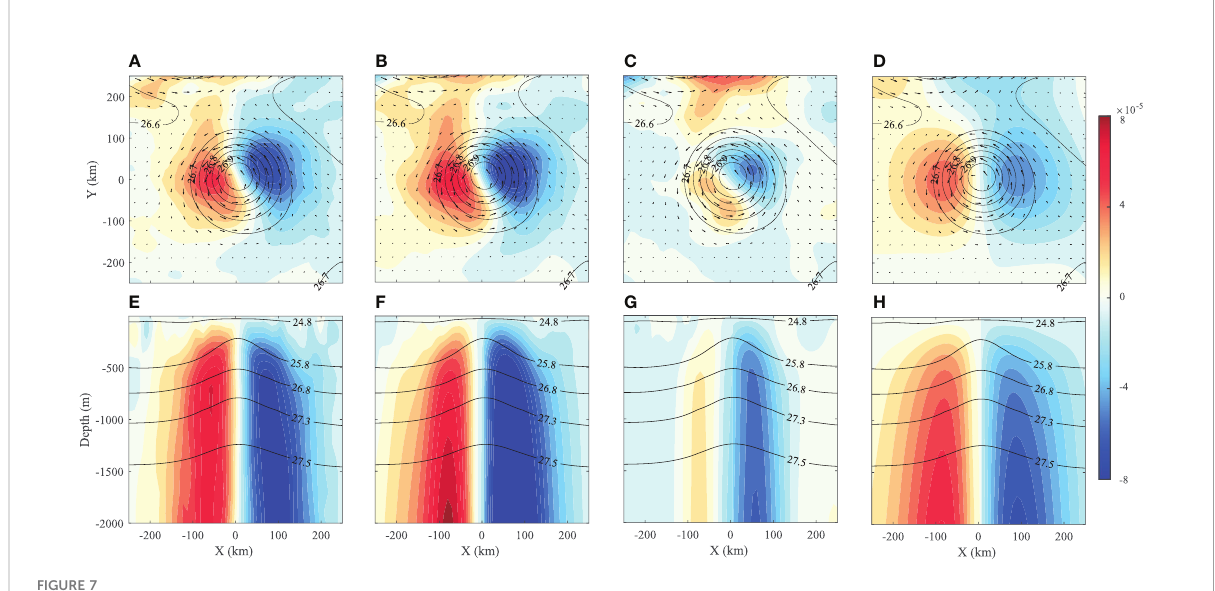
FIGURE 7 Same as Figure 5 except for the case of the Kuroshio extension cold eddy